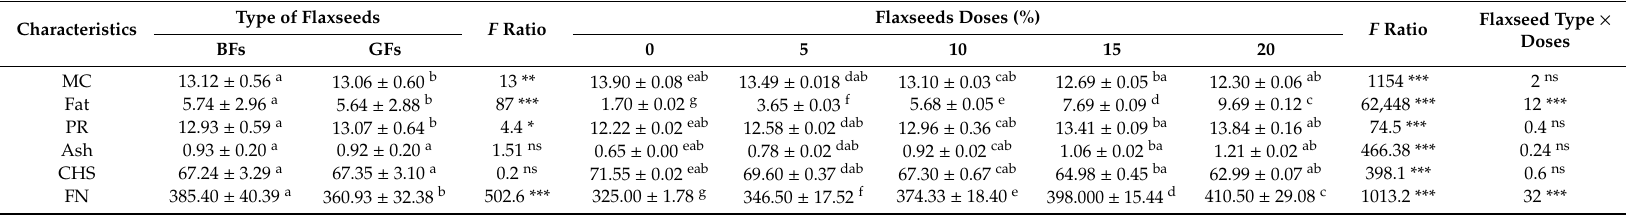
Table 3. The analysis of the variance of brown (BFs) and golden (GFs) flaxseeds addition to the strong quality flour for bread-making. Characteristics